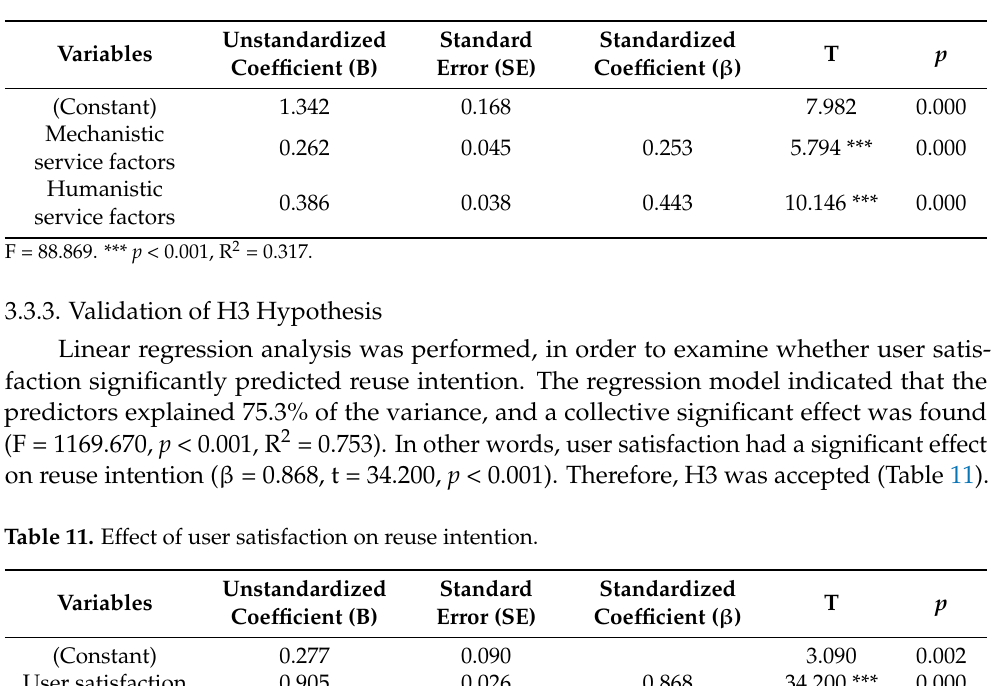
Table 10. Effect of service factors on reuse intention.